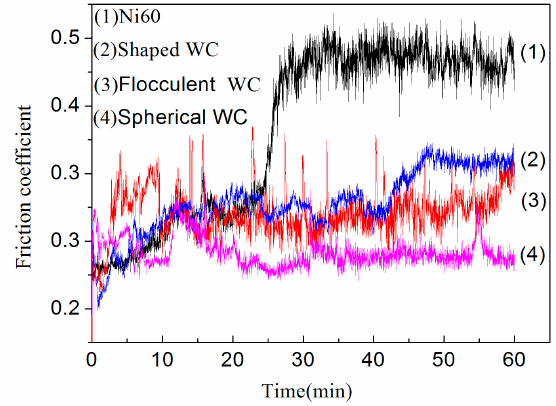
Figure 4. Friction coefficient curve of the cladding coating.